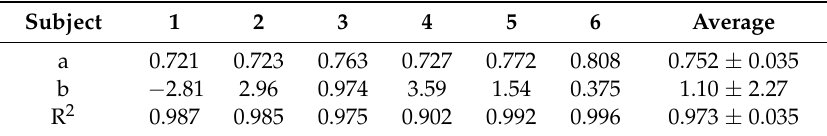
Table 5. Pitch data relation: smart wear data = a × camera data + b, R 2 .